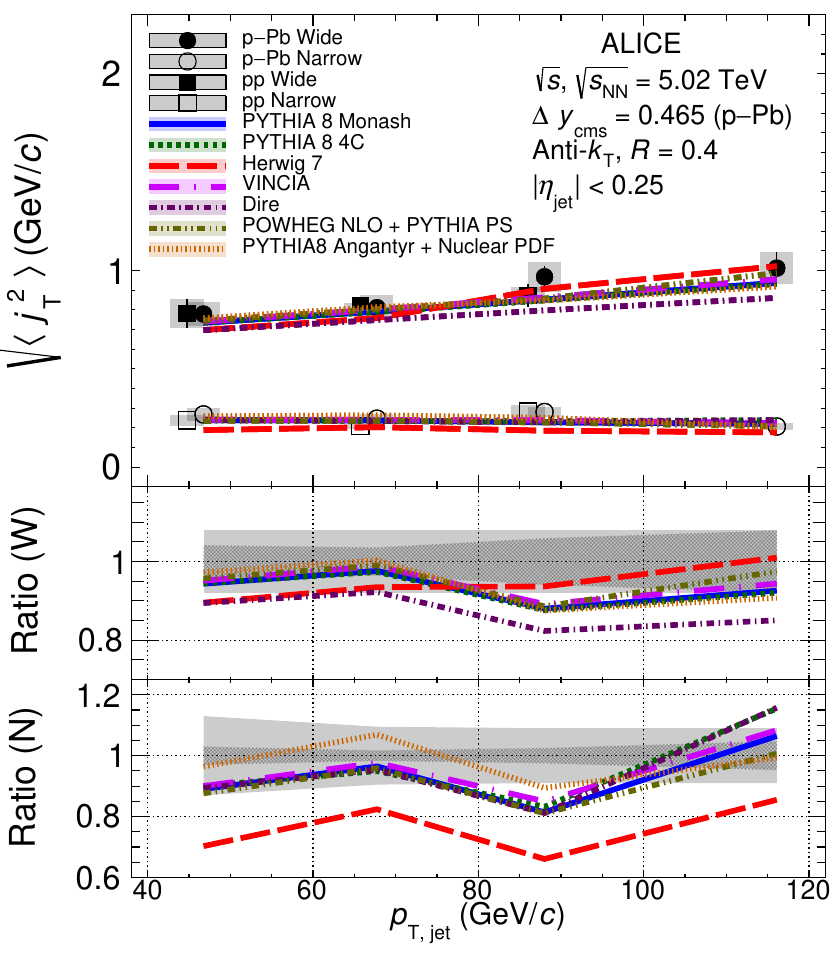
Figure 5. RMS values extracted from the fits for the Gaussian (narrow) and inverse gamma (wide) components. The middle and bottom plots show ratios of models to data for the wide and narrow components, respectively. The grey filled bands with (without) a hatched line in the ratio plots represent the statistical (systematic) uncertainties of the p-Pb data. Note that pp data points are shifted by -2 GeV/ c on the horizontal axis to be distinguished from p-Pb data